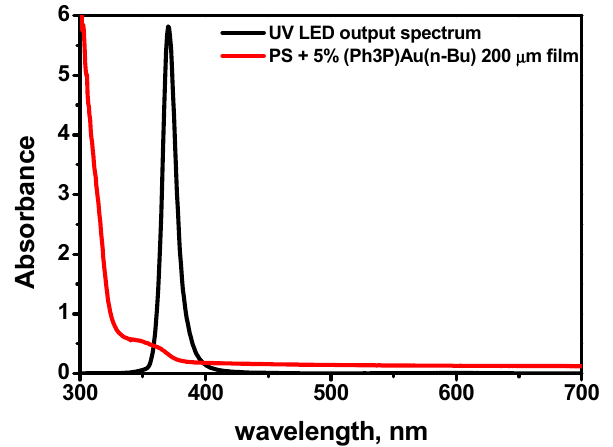
Figure 1. The optical spectrum of the initial just-obtained polystyrene films with (Ph 3 P)Au( n -Bu) precursor (5 wt %) (red) and UV LED emission spectrum (arbitrary units) (black).